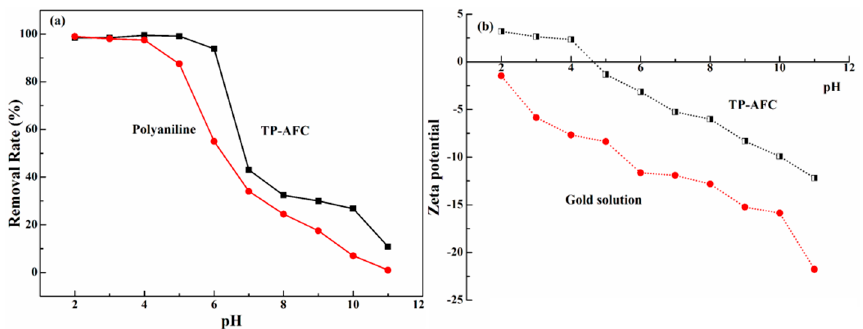
Figure 3. ( a ) Effect of pH on the Au(III) adsorption by polyaniline and TP-AFC and ( b ) zeta potential of TP-AFC and gold solution.